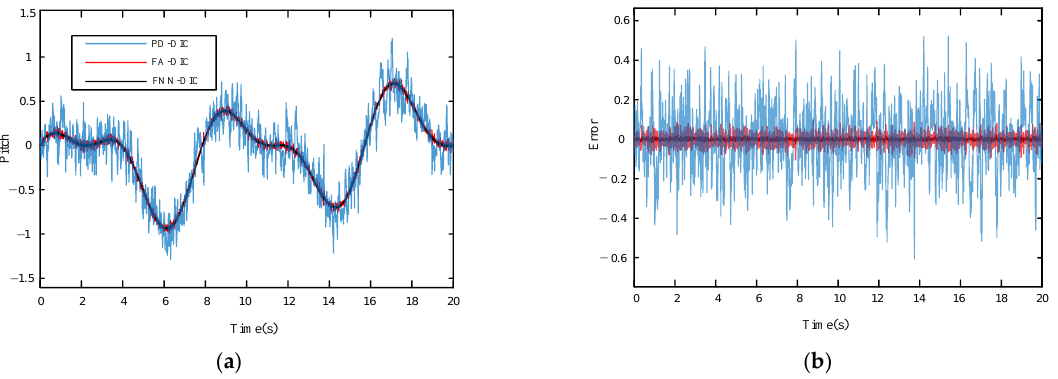
Figure 12. Pitch angle tracking results under atmospheric disturbance: ( a ) Pitch angle tracking curve, and ( b ) tracking error curve.